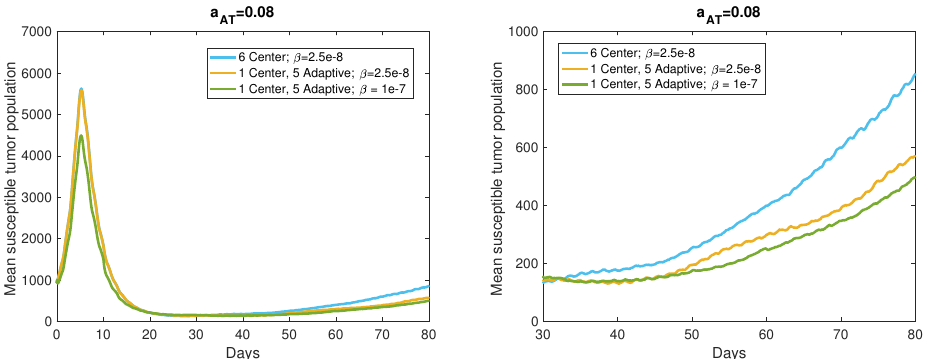
Figure 9. Means generated from 40 realizations for each parameter set, with antigenicity level a AT = 0.08. The blue curve is generated from simulations with six center viral doses and viral infection rate, β = 2.5 × 10 − 8 pfu − 1 h − 1 , the yellow curve is generated from simulations with one center dose and five adaptive doses and β = 2.5 × 10 − 8 , and the green curve is generated from simulations with one center dose and five adaptive doses and β = 1 × 10 − 7 . The graph on the right is a zoomed in version of the full trajectories on the left.